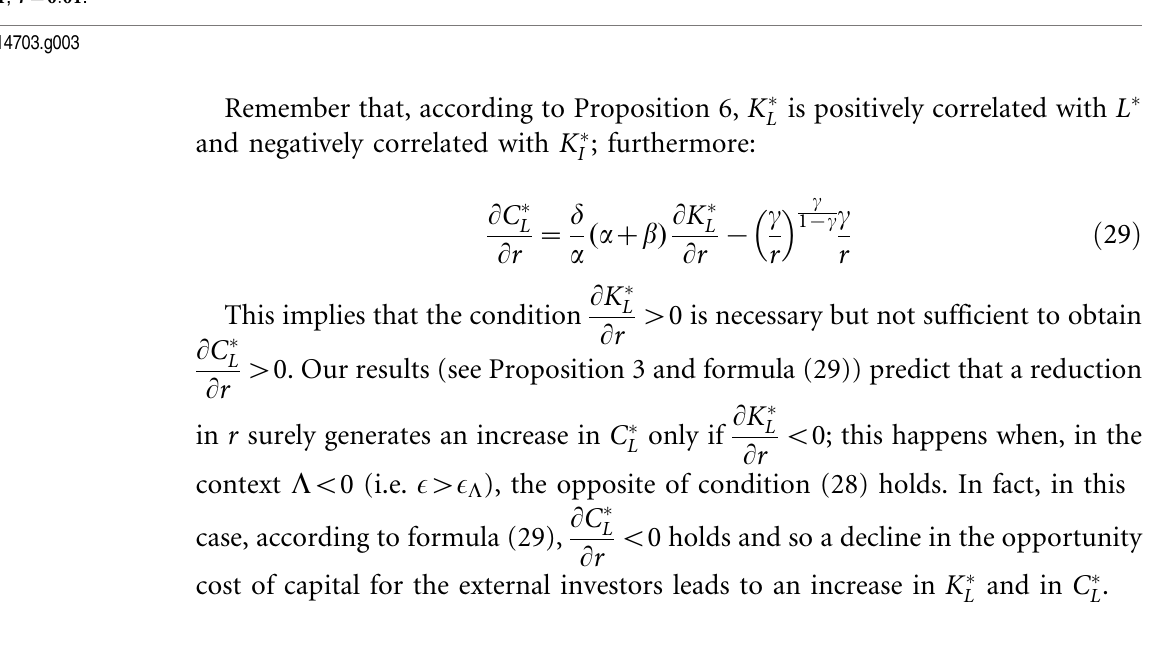
Fig. 3. Values of K (cid:2) b ~ 0 : 35 , ª ~ 0 : 2 , d ~ 0 : 01 , r ~ 0 : 01